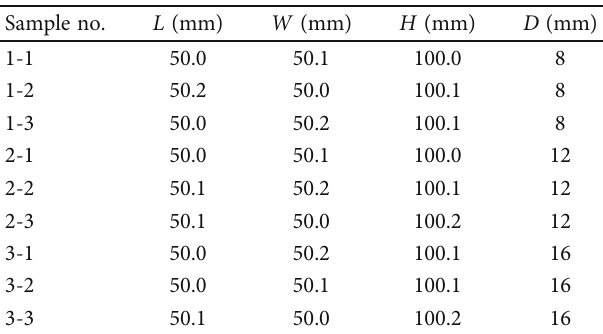
Table 1: Geometry parameters of